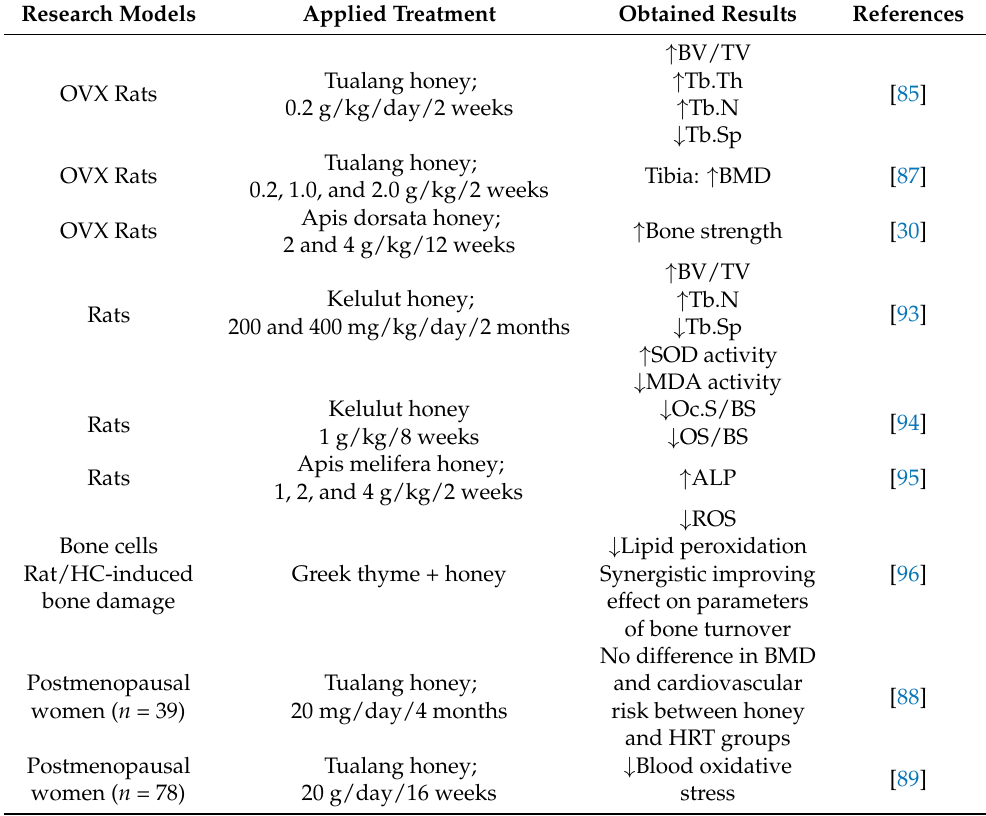
Table 1. Preclinical and clinical studies on the anti-osteoporotic potential of